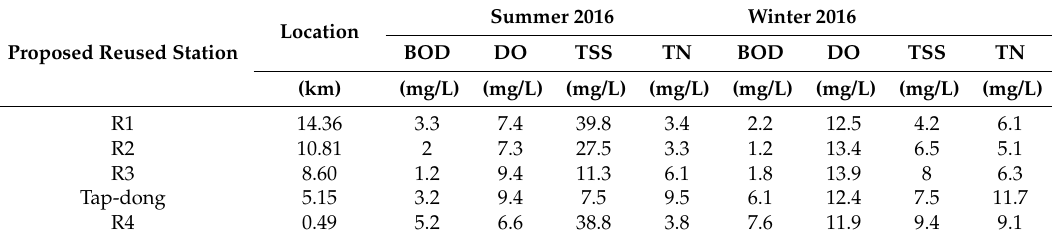
Table 2. Mean water quality for summer and winter 2016 at proposed reused stations.